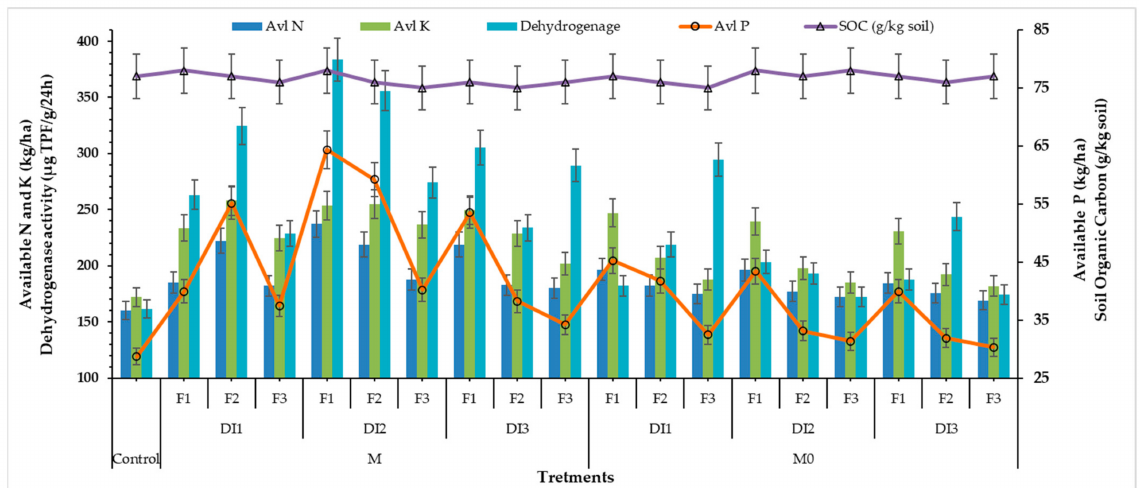
Figure 2. Nutrient availability (NPK, kg/ha) influenced by mulching and fertigation system (pooled data of two-year experiment). M (mulch), M0 (no mulch); DI (drip irrigation level: 100% CPE, 80% CPE, 60% CPE); F (fertigation level 100% RDF, 80% RDF, 60%